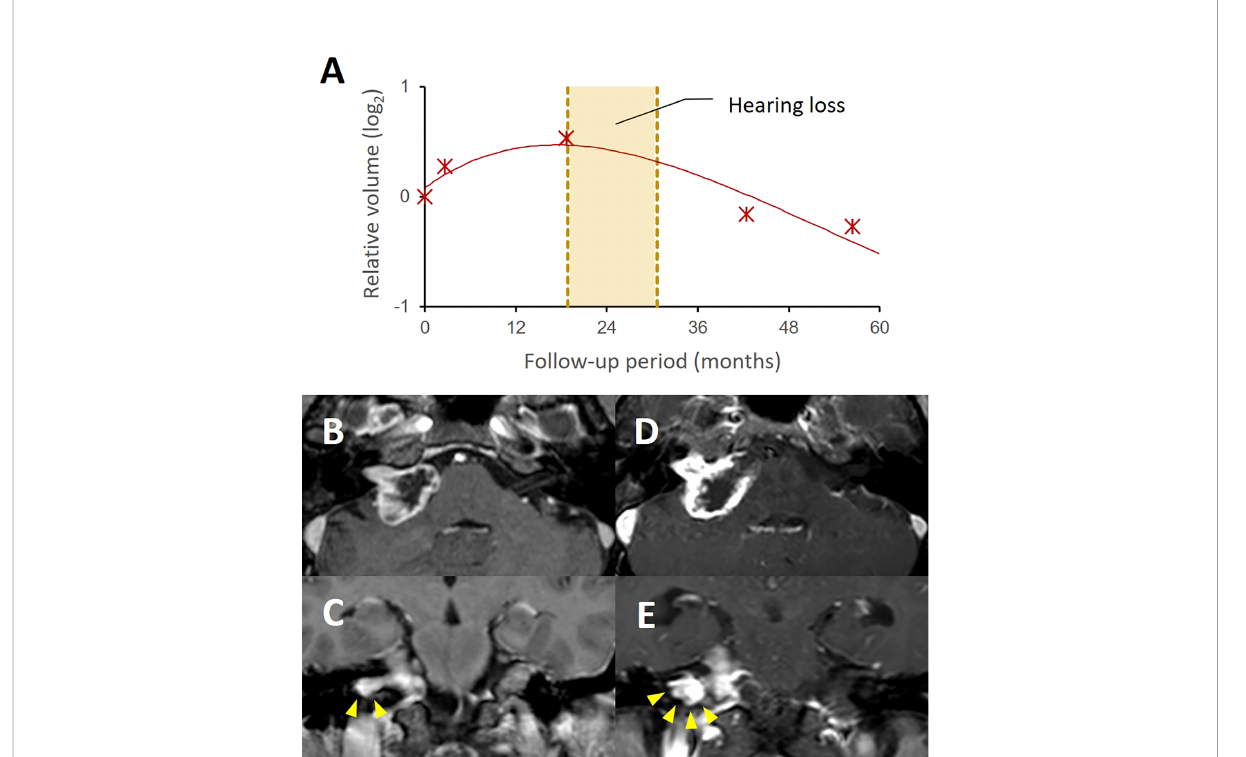
FIGURE 4 A case with progressive hearing loss during pseudoprogression after stereotactic radiosurgery. A group II case showed a typical tumor volume response pattern with transient volume increase up to 42.5% of initial volume after SRS (A) . The patient presented progressive hearing loss during pseudoprogression (yellow box). The follow-up MRI (D, E) showed a signi fi cant volume expansion, compared to the pretreatment MRI (B, C) . In this case, the increased extent of the intracanalicular part of the tumor was notable as shown in the coronal images ( E , arrowheads), which possibly caused cochlear nerve compression in the internal auditory